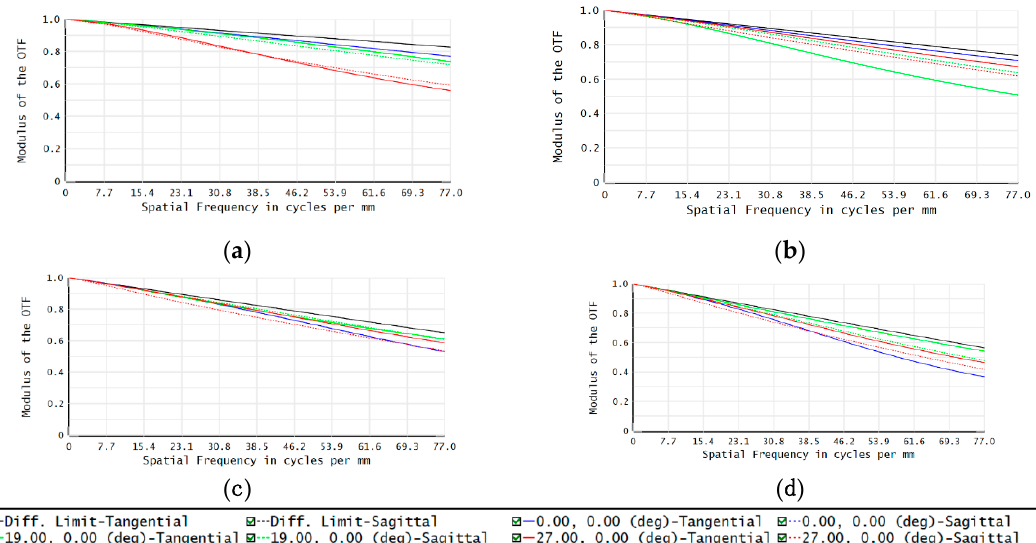
Figure 6. Modulation transfer function (MTF) of the front objective lens for ( a ) 400 nm, ( b ) 600 nm, ( c ) 800 nm, and ( d ) 1000 nm.